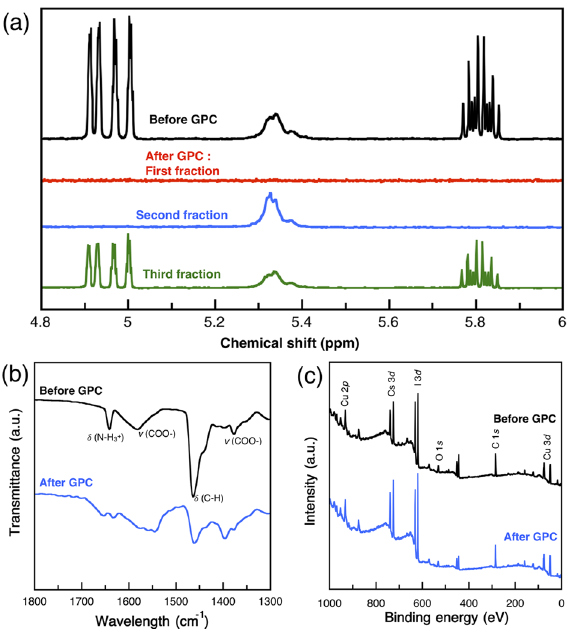
Figure 2. The surface analysis of ( a ) 1 H NMR spectra of NCs collected from different fraction of GPC in chloroform-d1, ( b ) FTIR spectra, and ( c ) XPS spectra before and after GPC